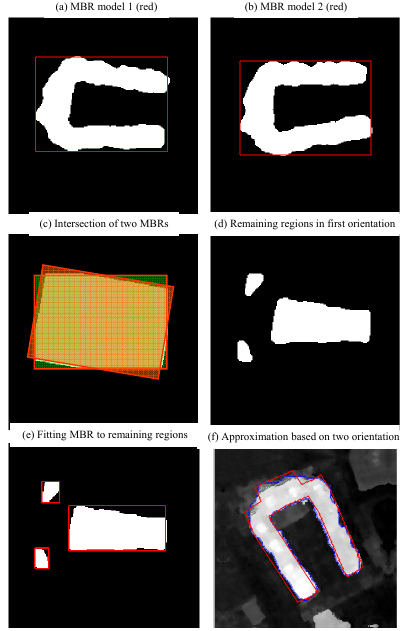
Figure 4: CMBR based polygon approximation ing to each orientation produces the first approximation of non- rectangular building (cf. Figure 4(e), yellow region). The first approximation area is subtracted from original binary region to generate the remaining regions which should be approximated.